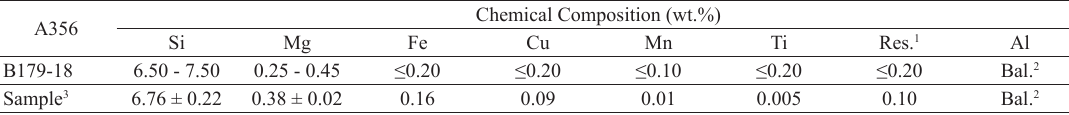
Chemical Composition (wt.%)